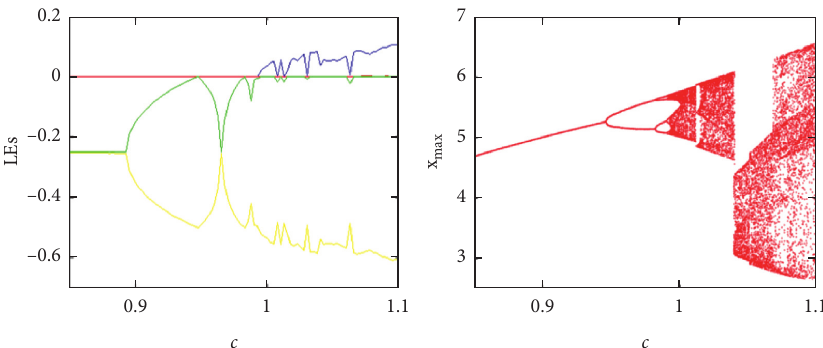
Figure 8: Lyapunov exponent spectrum and bifurcation diagram of system (1) with (a) � 0.8, (b) � 0.5, (d) � 0.1 and initial condition IC � (0.01, 0.01, 0, 0), when (c) varies in [0.85,